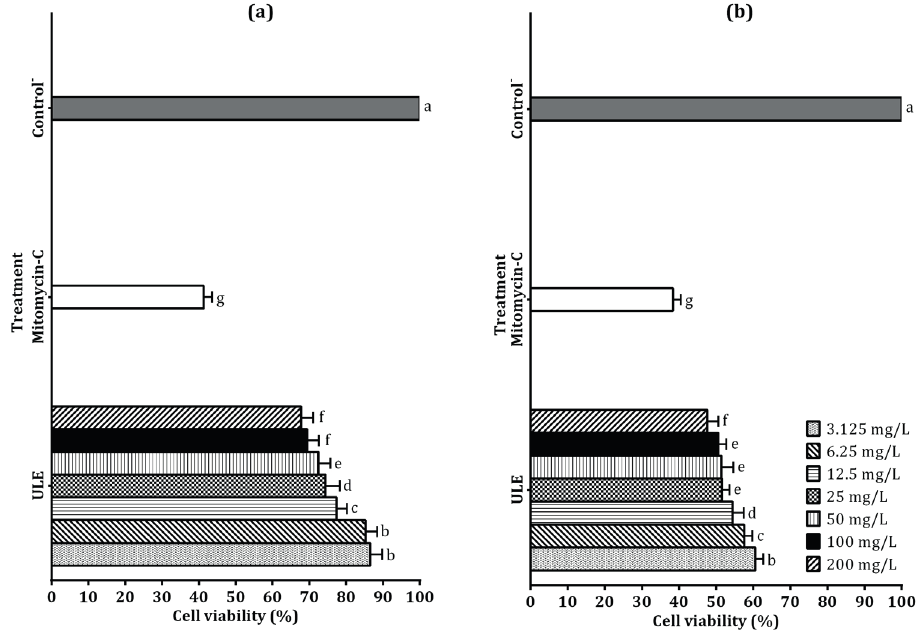
Figure 2 - Viability rates in the cells exposed to ULE (a) for PMGN cells (b) for U87MG cells. Each value is expressed as mean ± standard deviation ( n = 3). Values followed by different small letters differ significantly at p <